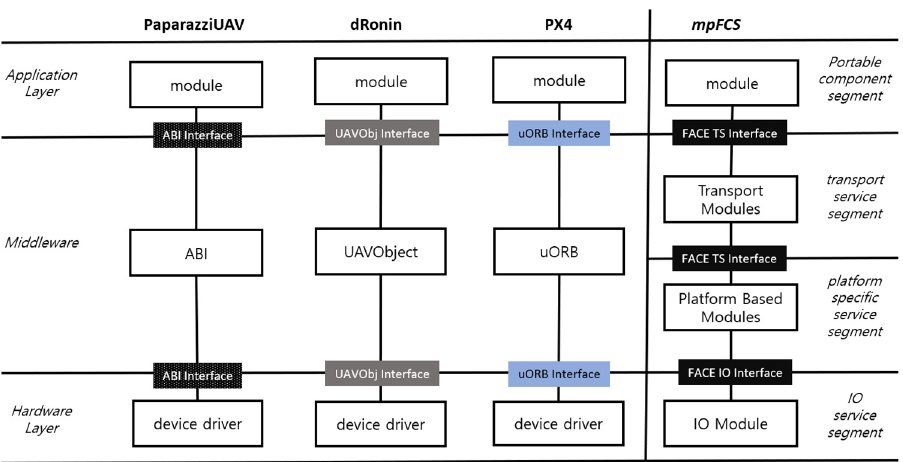
Figure 17. A comparison on layers and interfaces of related work and the mpFCS.